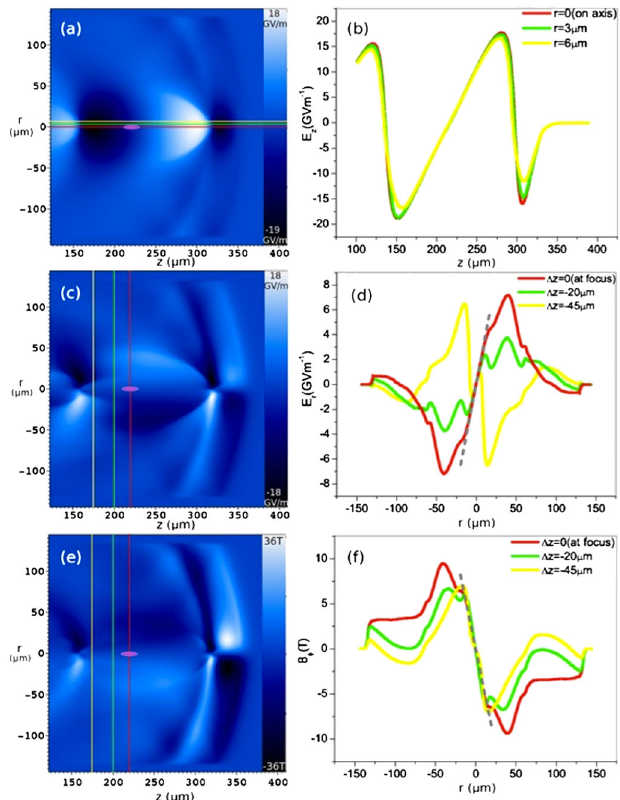
FIG. 3. VORPAL simulation results of the plasma wakefields acting on the released electrons. The left three figures (a), (c), (e) are color plots of the spatial distribution and intensity of wake- fields E (cid:10) , E r , B (cid:7) , respectively, while the right three figures (b), (d), (f) are lineout plots of the fields at the indicated positions. While the corresponding simulation did not include the laser pulse, the laser pulse position of the laser pulse assumed in the numero-analytical analysis is indicated by the reddish